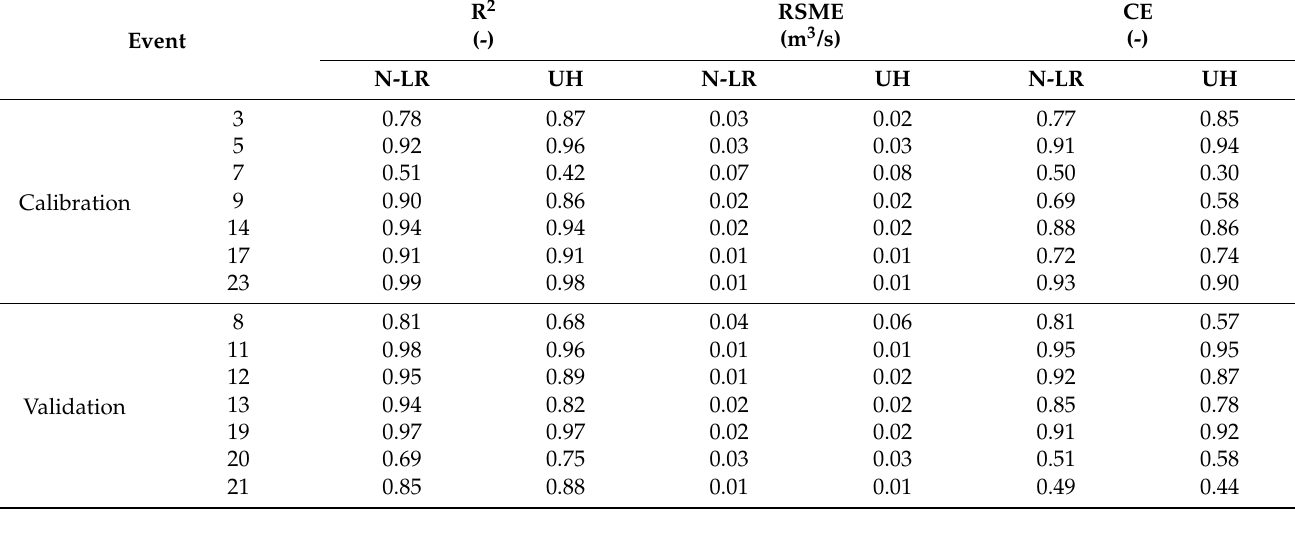
Figure 6. Comparison plot between measured and predicted total volume, for N-LR (light grey) and UH (dark grey) model in either calibration (solid circle) or validation (solid triangle) step.